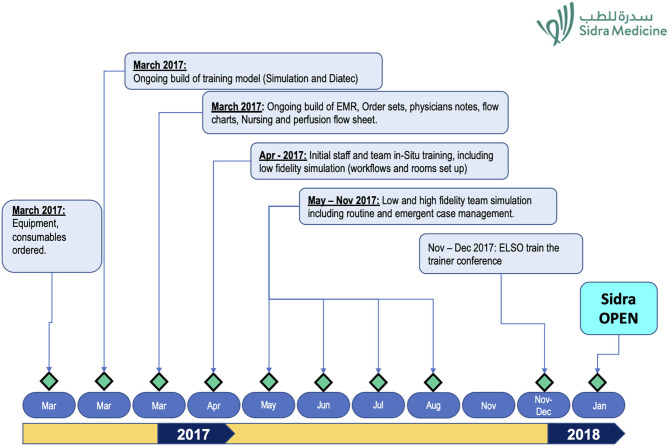
Sidra ECMO service milestones.